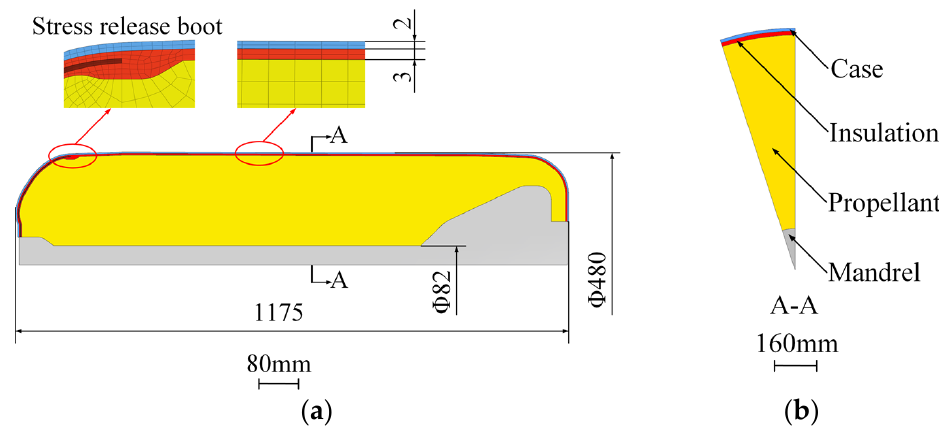
Figure 2. SRM model and mesh. ( a ) 3D SRM model. ( b ) Cross section.